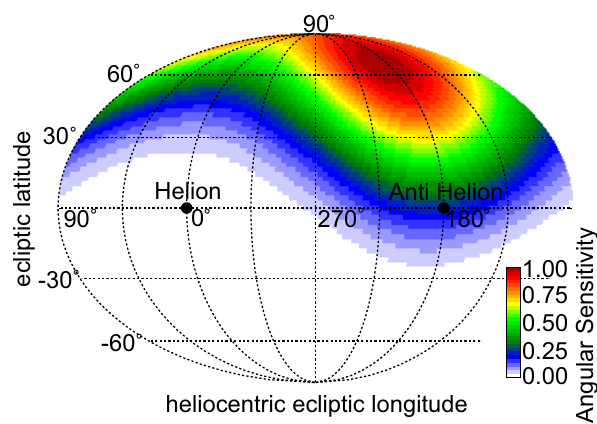
Fig. 10. MAARSY’s time integrated angular sensitivity for the ob- servation time during the ECOMA Geminid campaign in accor- dance with Chau et al.